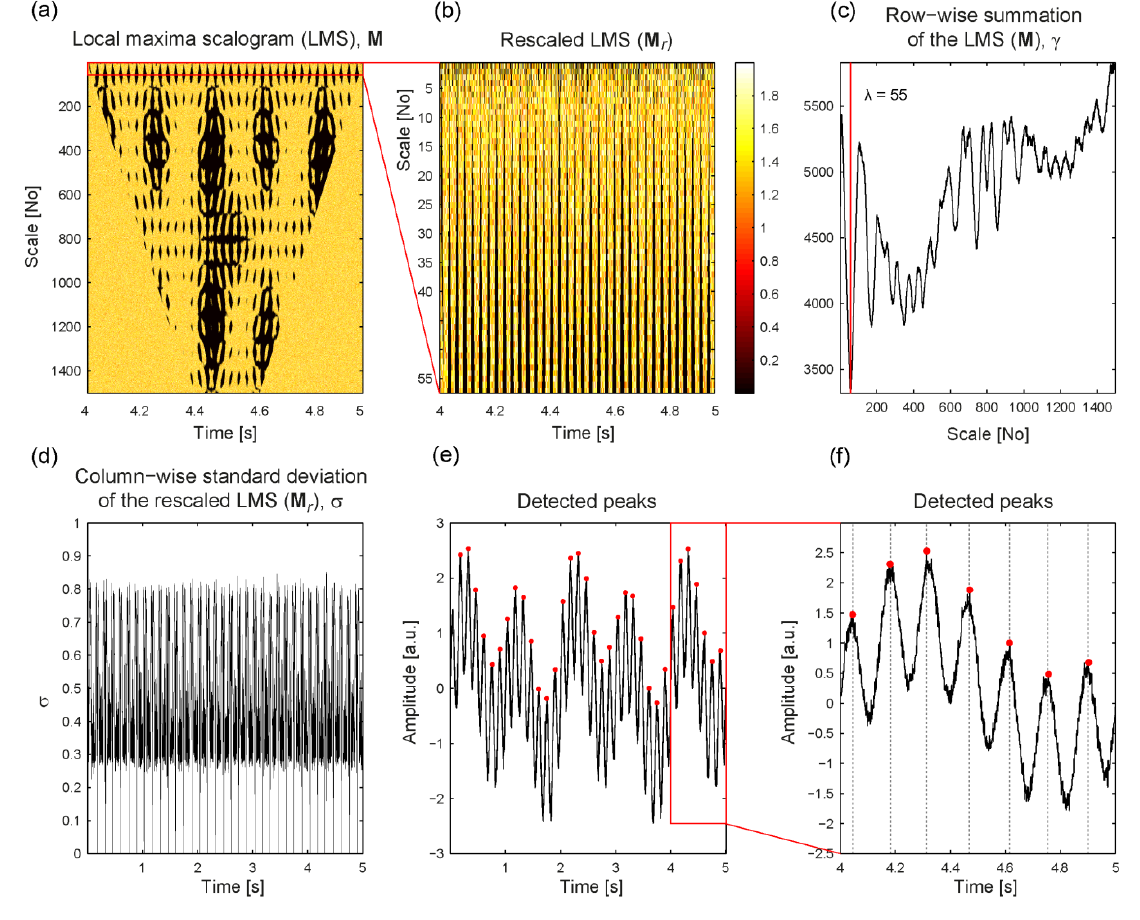
Figure 2. Example of applying the AMPD algorithm to a simulated signal. ( a ) Local maxima scalogram, calculated from scale 1 to L , with / 2 1 L N     and N the length of the signal ( N = 3000); ( b ) Rescaled local maxima scalogram (LMS) according to the detected global minimum as shown in ( c ); ( d ) Calculated row-wise standard deviation of the rescaled LMS; ( e ) and ( f ) Detected